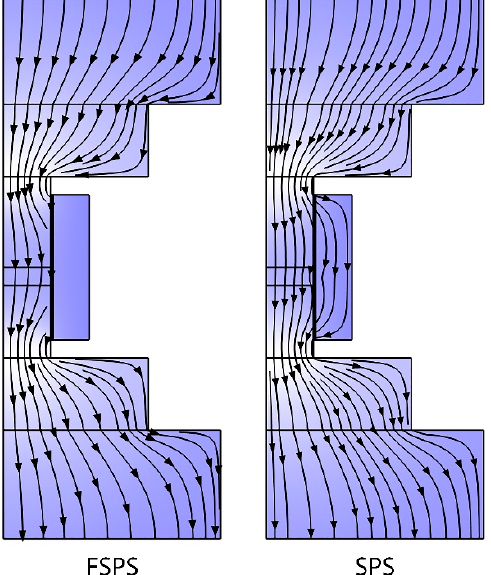
Figure 8. Streamlines of current densities for FSPS and SPS modes.